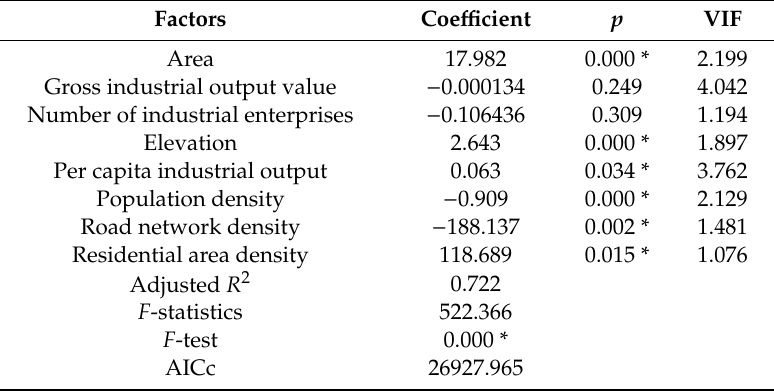
Table 1. Parameter estimation and test results of the OLS model.